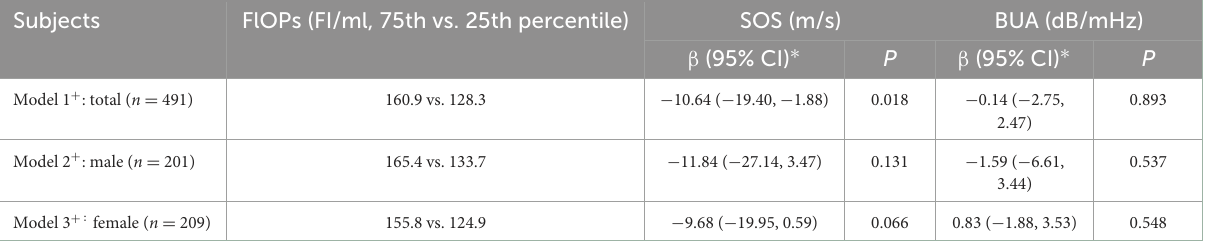
TABLE 2 Fluorescent oxidation products (FlOPs) and quantitative ultrasound (QUS) parameters: multivariable linear regression analysis.